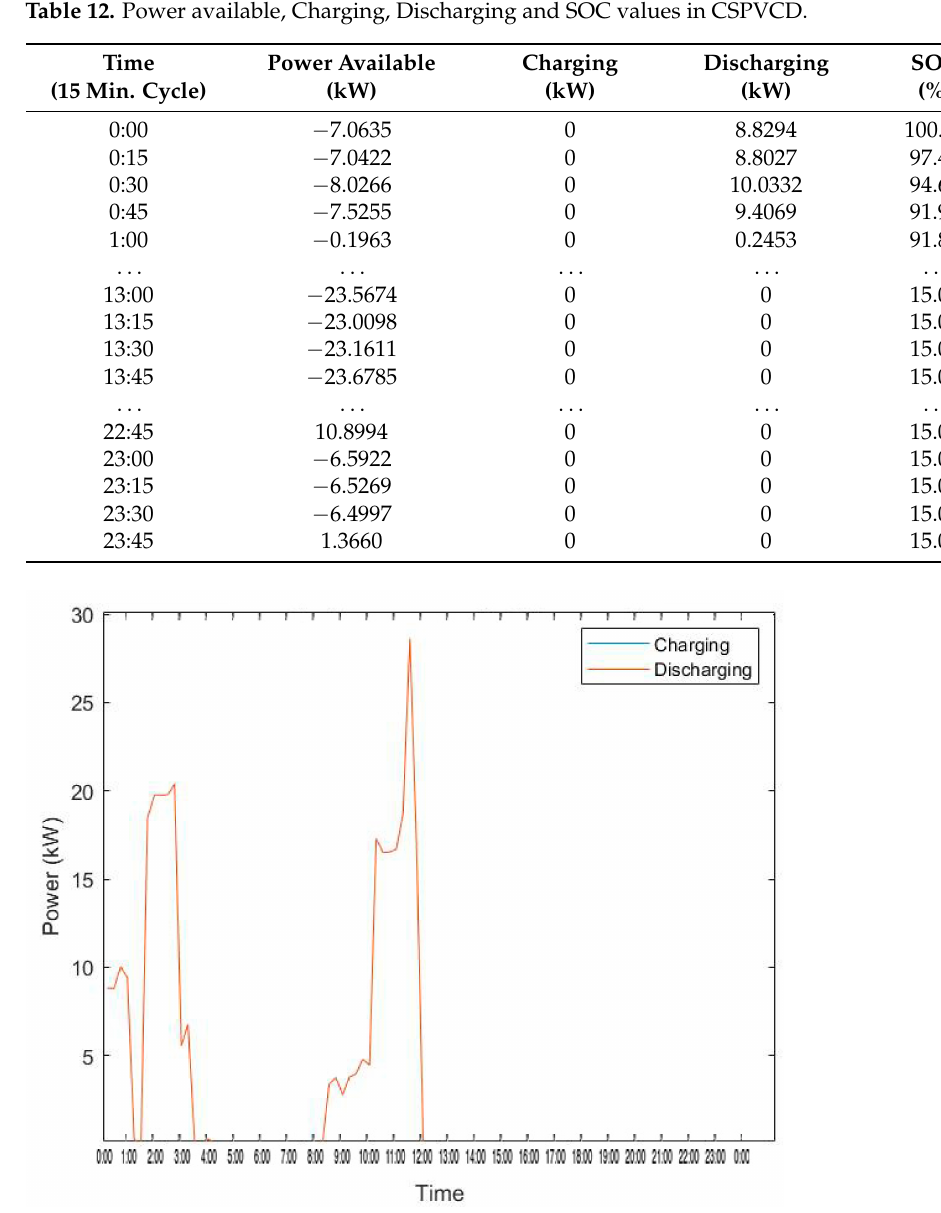
Figure 24. Charging and Discharging of Street Battery in